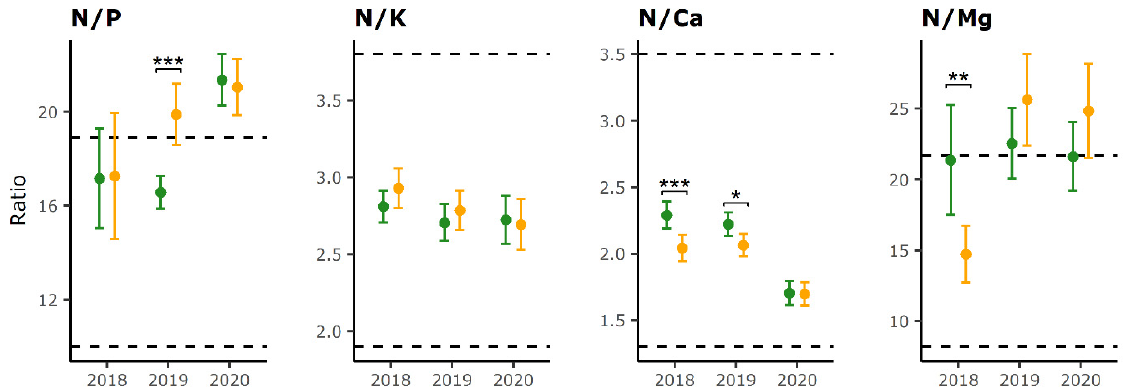
Figure 2. Mean foliar ratios (dots) and confidence intervals (vertical bars) for LD (green color) and HD trees (orange color) on all plots within sampling years. Dotted lines represent lower and upper critical value for normal range of foliar ratios for common beech according to Mellert and Goettlein [40]. Only significant differences in foliar ratios between LD and HD categories determined by the Holm–Bonferroni method are indicated (* p < 0.05, ** p < 0.01, *** p < 0.001). Table 3. Results of Holm pairwise comparisons of foliar nutrient ratios within a defoliation category and between sampling years (ns–not significant, * p < 0.05, ** p < 0.01, *** p < 0.001).